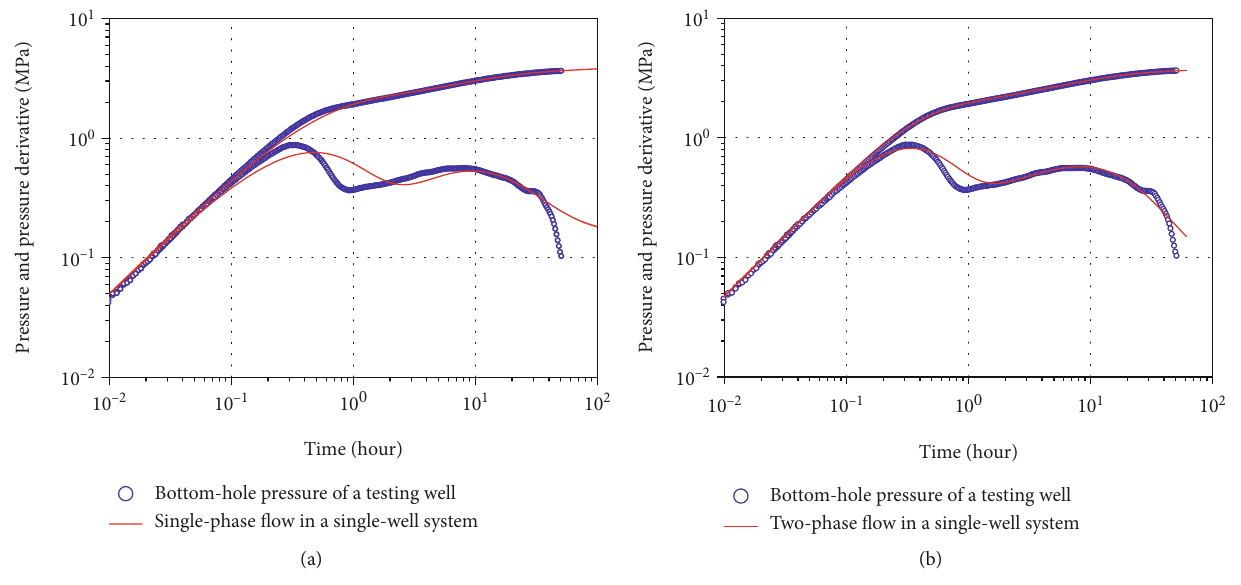
Figure 18: History matching results computed by two traditional models: (a) history matching using the composite model for single-phase fl ow in a single-well system; (b) history matching using the composite model for two-phase fl ow in a single-well system.